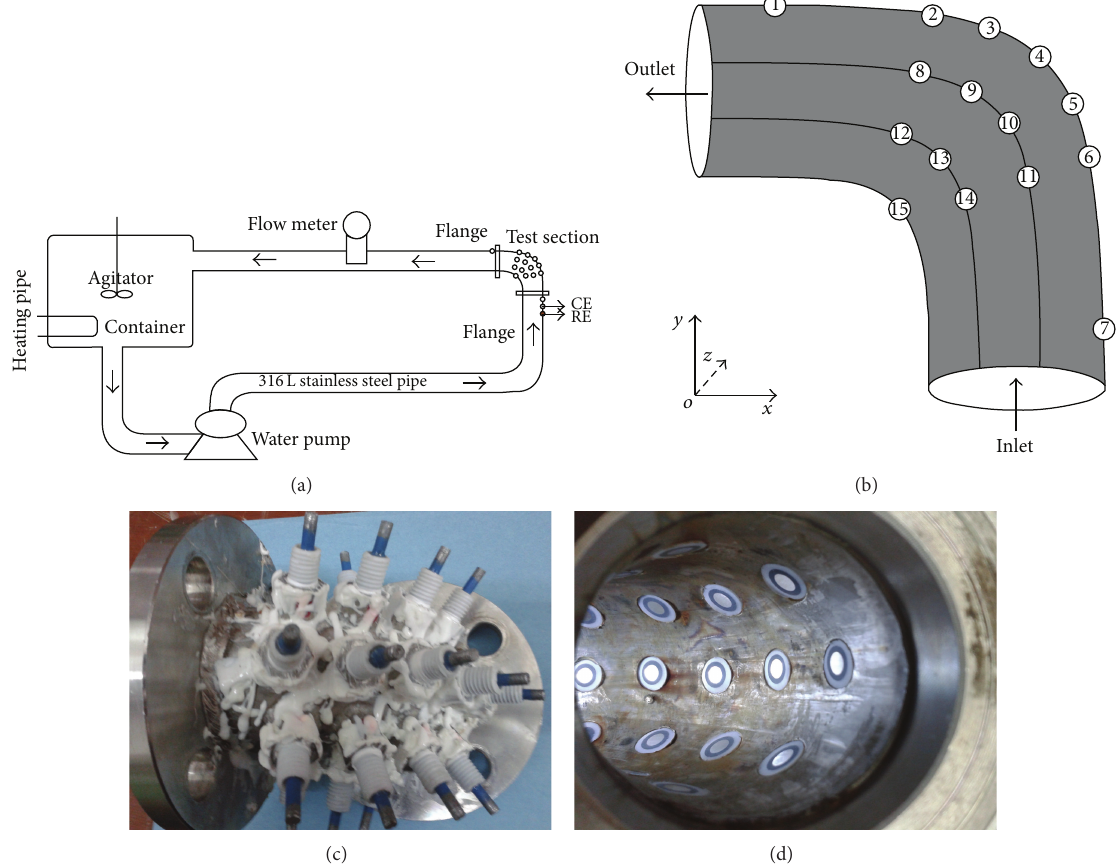
Figure 1: Schematic diagram of FAC loop test system and array electrodes: (a) loop test system, (b) distribution of array electrodes in test section, (c) the assembly of elbow test section, and (d) distribution of array electrodes at the inner wall of